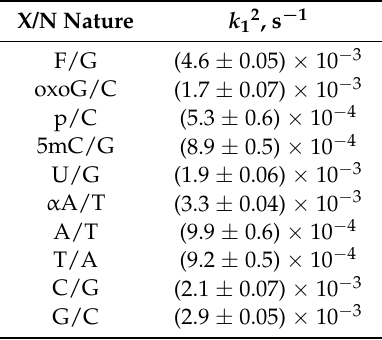
Table 2. The rate constants k 12 of the interaction of APE1 with substrates Exo-aPu 2 -X/N .